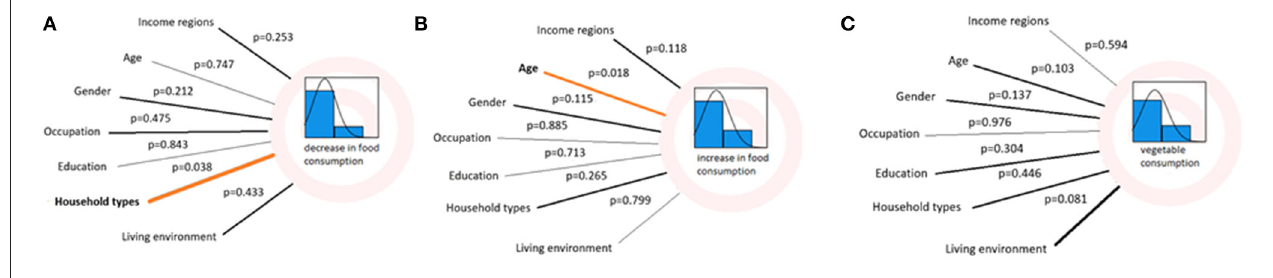
FIGURE 3 | Results of binary logistic regression models for correlations between personal factors and housing situations and (A) decrease in food quantity, (B) increase in food quantity, (C) change in vegetable consumption (orange line indicates a correlation with p < 0.05).